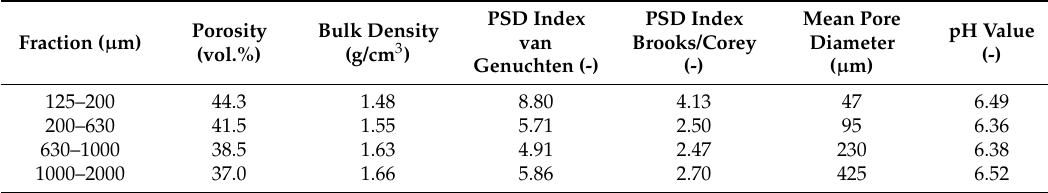
Table 2. Characterization of the grain size fractions.